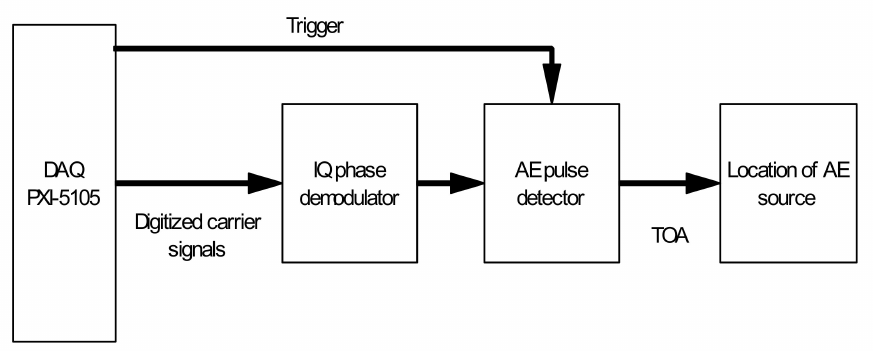
Figure 9. Acquisition and digital processing for TOA measurement and location of the AE source.